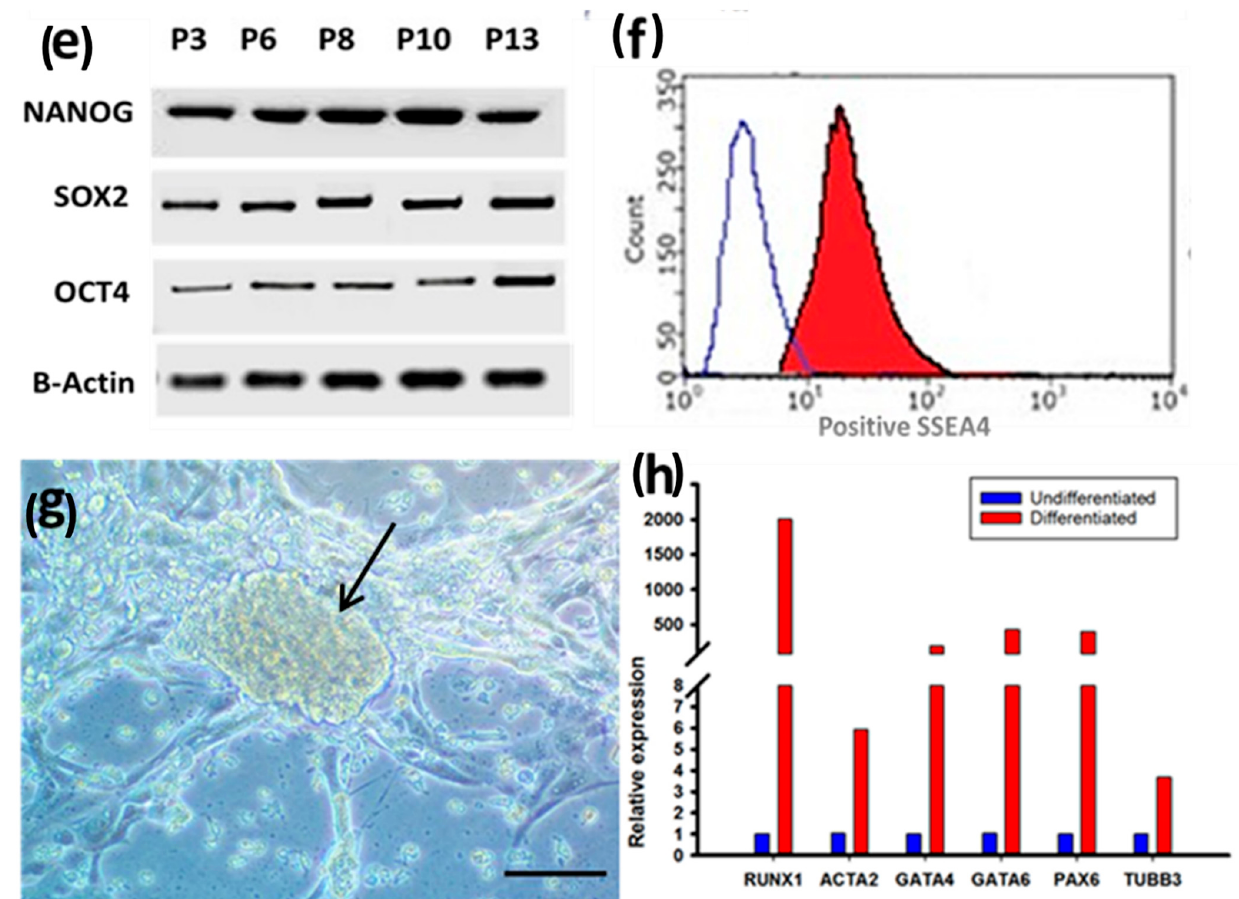
Figure 2. IPSCs characterization showed ( a , b ): Dermal fibroblasts cultured at day 0 and expanded for 7 days; ( c ): Representative images of iPSCs colonies at 4 weeks transfection after re-plating and re-expansion; ( d ): RT-PCR assessment for pluripotent genes (OCT4, SOX2,c-MYC, TERT & NANOG) in different 5 IPSCs passages. ( e ): Western blot assay for protein level of OCT4, SOX2 and Nanog. ( f ): Flow cytometry to detect SSEA-4 in iPSCs. ( g ): Embryoid formation with spontaneous tri-linage differentiation; ( h ): qRT-PCR assessment for iPSCs spontaneous differentiation genes for ectoderm (GATA4, GATA6), mesoderm (RUNX1 & ACTA2), and endoderm (TUMM3 & PAX6).